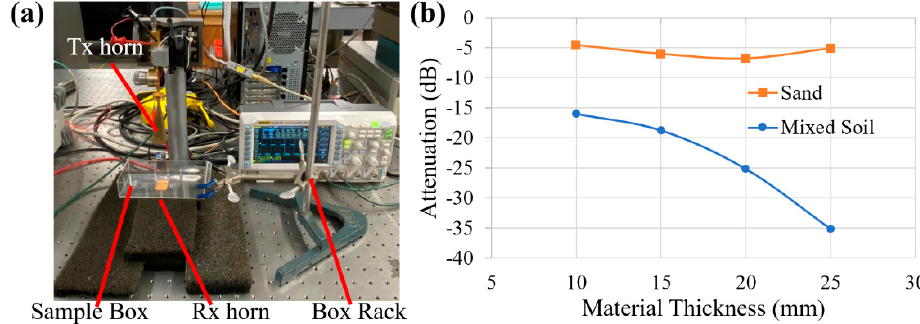
Figure 14. W–band attenuation ( a ) testing platform and ( b ) related experiment results.